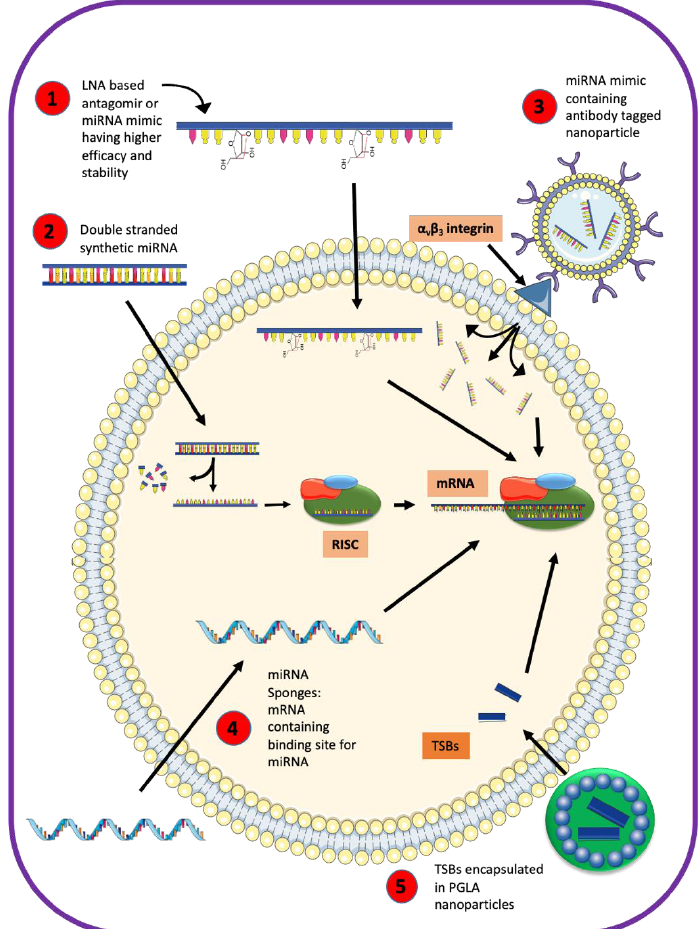
Figure 4. Approaches for miRNA-based therapeutic strategies. The following strategies increase stability, efficacy, and specificity of miRNA-based approaches: (1) locked nucleic acid (inaccessible RNA) modification is used in miRNA mimics or antisense-oligonucleotides (antagomirs), where the ribose moiety contains an extra bridge connecting the 2’ oxygen and 4’ carbon; (2) synthesis of double-stranded synthetic miRNA oligonucleotides; (3) coupling of miRNA mimics to antibody-coated nanoparticles; (4) delivery of mRNA expression vectors, containing miRNA sponges: mRNA containing a binding site for miRNA; and (5) using target site blockers (TSBs) encapsulated in poly-lactic-co-glycolic acid (PLGA) nanoparticles. LNA: locked nucleic acid; miRNA: micro RNA; mRNA: messenger RNA; RISC: RNA induced silencing complex; TSB: target site blockers; PLGA: poly-lactic-co-glycolic acid.